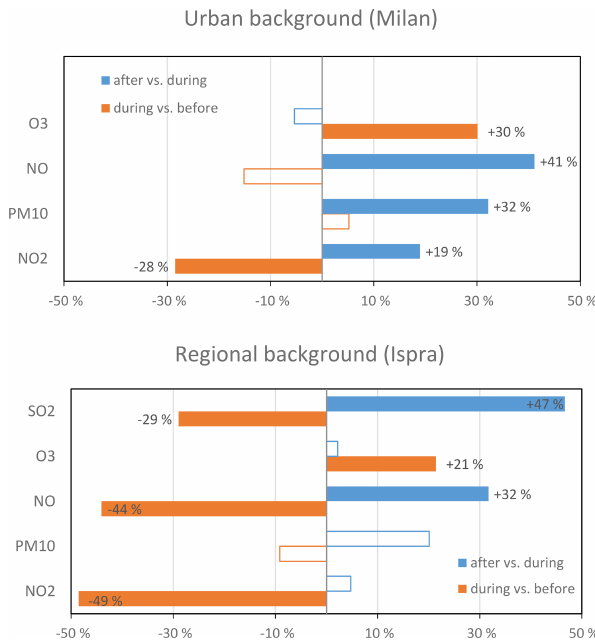
Figure 7. Changes in observed and expected concentrations for the 3 weeks before and after the lockdown in comparison with the 28d of lockdown corresponding to the CAMS daily forecasts above the median for each pollutant. Filled bars represent statistically signif- icant differences. Empty bars represent differences that are not sig- nificantly different from